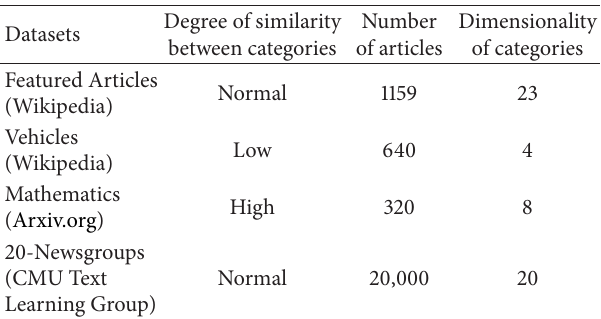
Table 1: Datasets and their